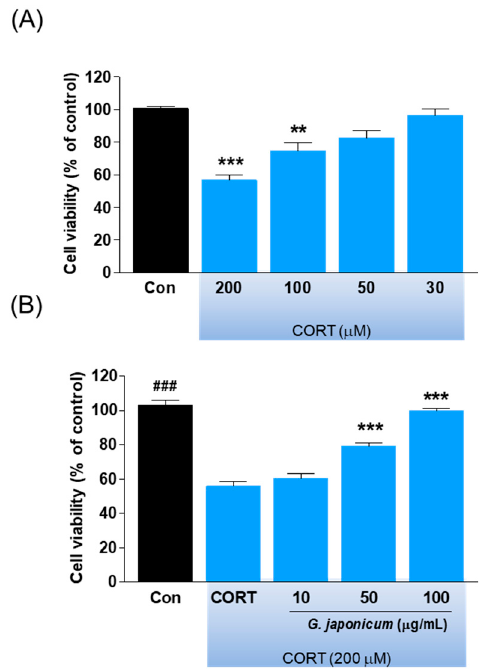
Figure 7. E ff ect of G. japonicum extract on CORT-induced cell viability in SH-SY5Y cells. ( A ) Dose- dependent cell death induced by CORT in SH-SY5Y human neuroblastoma cells. ( B ) G. japonicum extract showed neuroprotective e ff ects against CORT-induced toxicity in SH-SY5Y cells. Results are presented as mean ± SEM. ### p < 0.001 versus the normal group; *** p < 0.001 and ** p < 0.01 versus the CORT-treated control